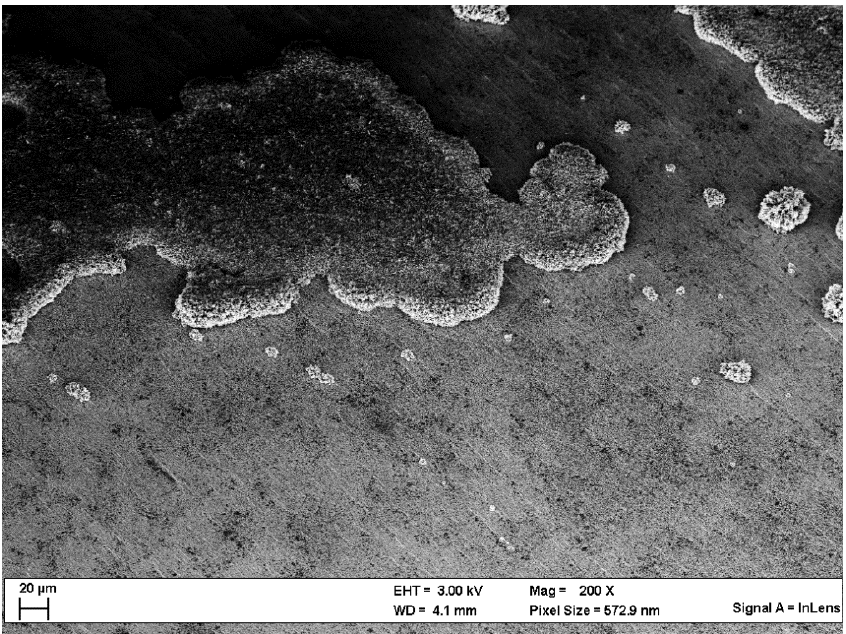
Figure 6. SEM image of lithium metal deposits on a copper foil, immediately after lithium deposition. Lithium was deposited for 360 s with a current density of 1 mA cm − 2 from 1 M LiPF in EC:DEC (3:7, by 6